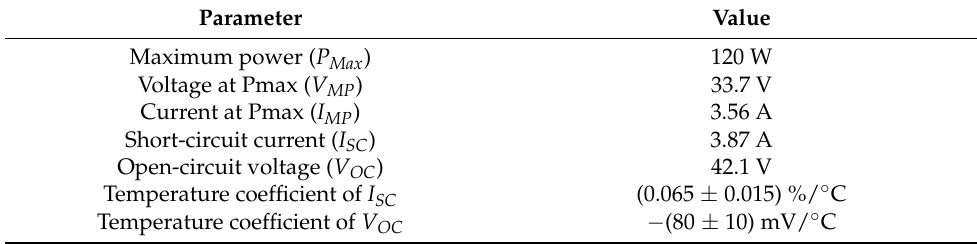
Table 1. Multi-crystalline module parameters of BP Solar MSX-120 at STC. Parameter Value Maximum power ( P Max ) 120 W Voltage at Pmax ( V MP ) 33.7 V Current at Pmax ( I MP ) 3.56 A Short-circuit current ( I SC ) 3.87 A Open-circuit voltage ( V OC ) 42.1 V Temperature coefficient of I SC (0.065 ± 0.015) %/ ◦ C Temperature coefficient of V OC − (80 ± 10) mV/ ◦